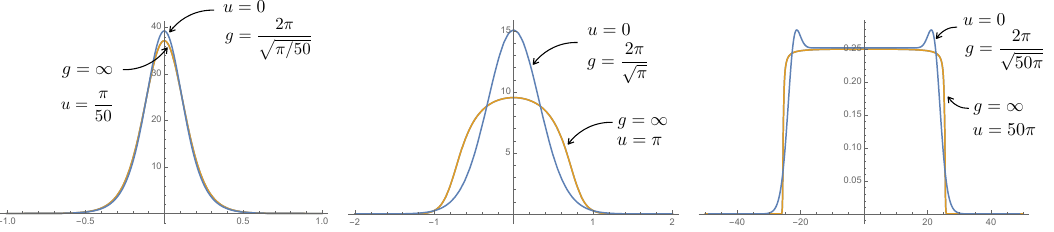
Figure 4 . Energy density pro(cid:12)les of mirror pairs of domain walls (the blue lines for u the orange lines for g ). The mass and FI parameter are at the self-dual point ( (cid:24); m ) = (1 ; (cid:25) ! 1